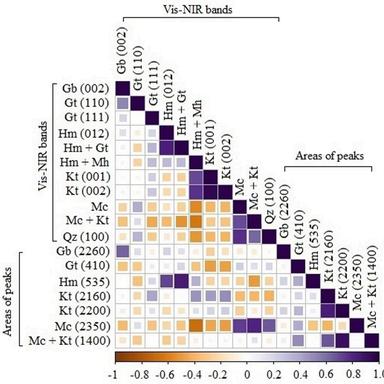
Correlograms of the bands associated with each mineral found in the Vis-NIR spectra for Brazilian soils: Gb (2260); Gt (410); Hm (535); Kt (2160); Kt (2200); Mc (2350); Mc + Kt (1400) and their respective areas in the XRD: Gb (002); Gt (110); Gt (111), Hm (012); Hm + Gt; Hm + Mh; Kt (001); Kt (002); Mc; Mc + Kt; Qz (110). Kt − Kaolinite, Mc − muscovite, Gb − gibbsite, Gt − goethite, Hm − hematite, Qz − quartz. The bluer the square, the greater the positive correlation; the more orange the square, the greate